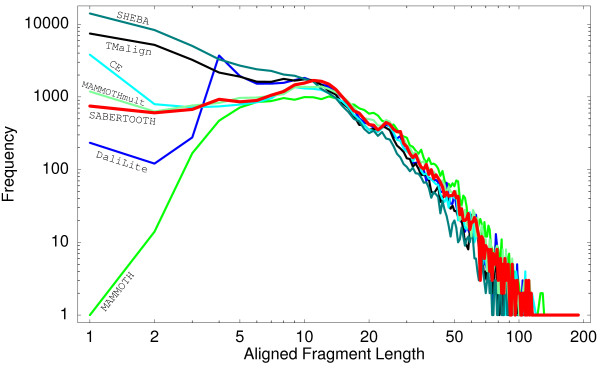
Aligned Fragment Length Histograms. Frequency of lengths of aligned fragments for alignments of the test set obtained with the algorithms assessed here. The behaviour found is very different for the different schemes. The total number of residues in fragments of sizes smaller than four sums up to 1.01% for SABERTOOTH, 0.13% for MAMMOTH, 1.18% for MAMMTOH-mult, 0.33% for DaliLite, 7.25% for TM-align, 2.22% for CE, and to 12.20% for SHEBA. Those aligned pairs are most likely not significant and should be omitted when the PSI is computed.